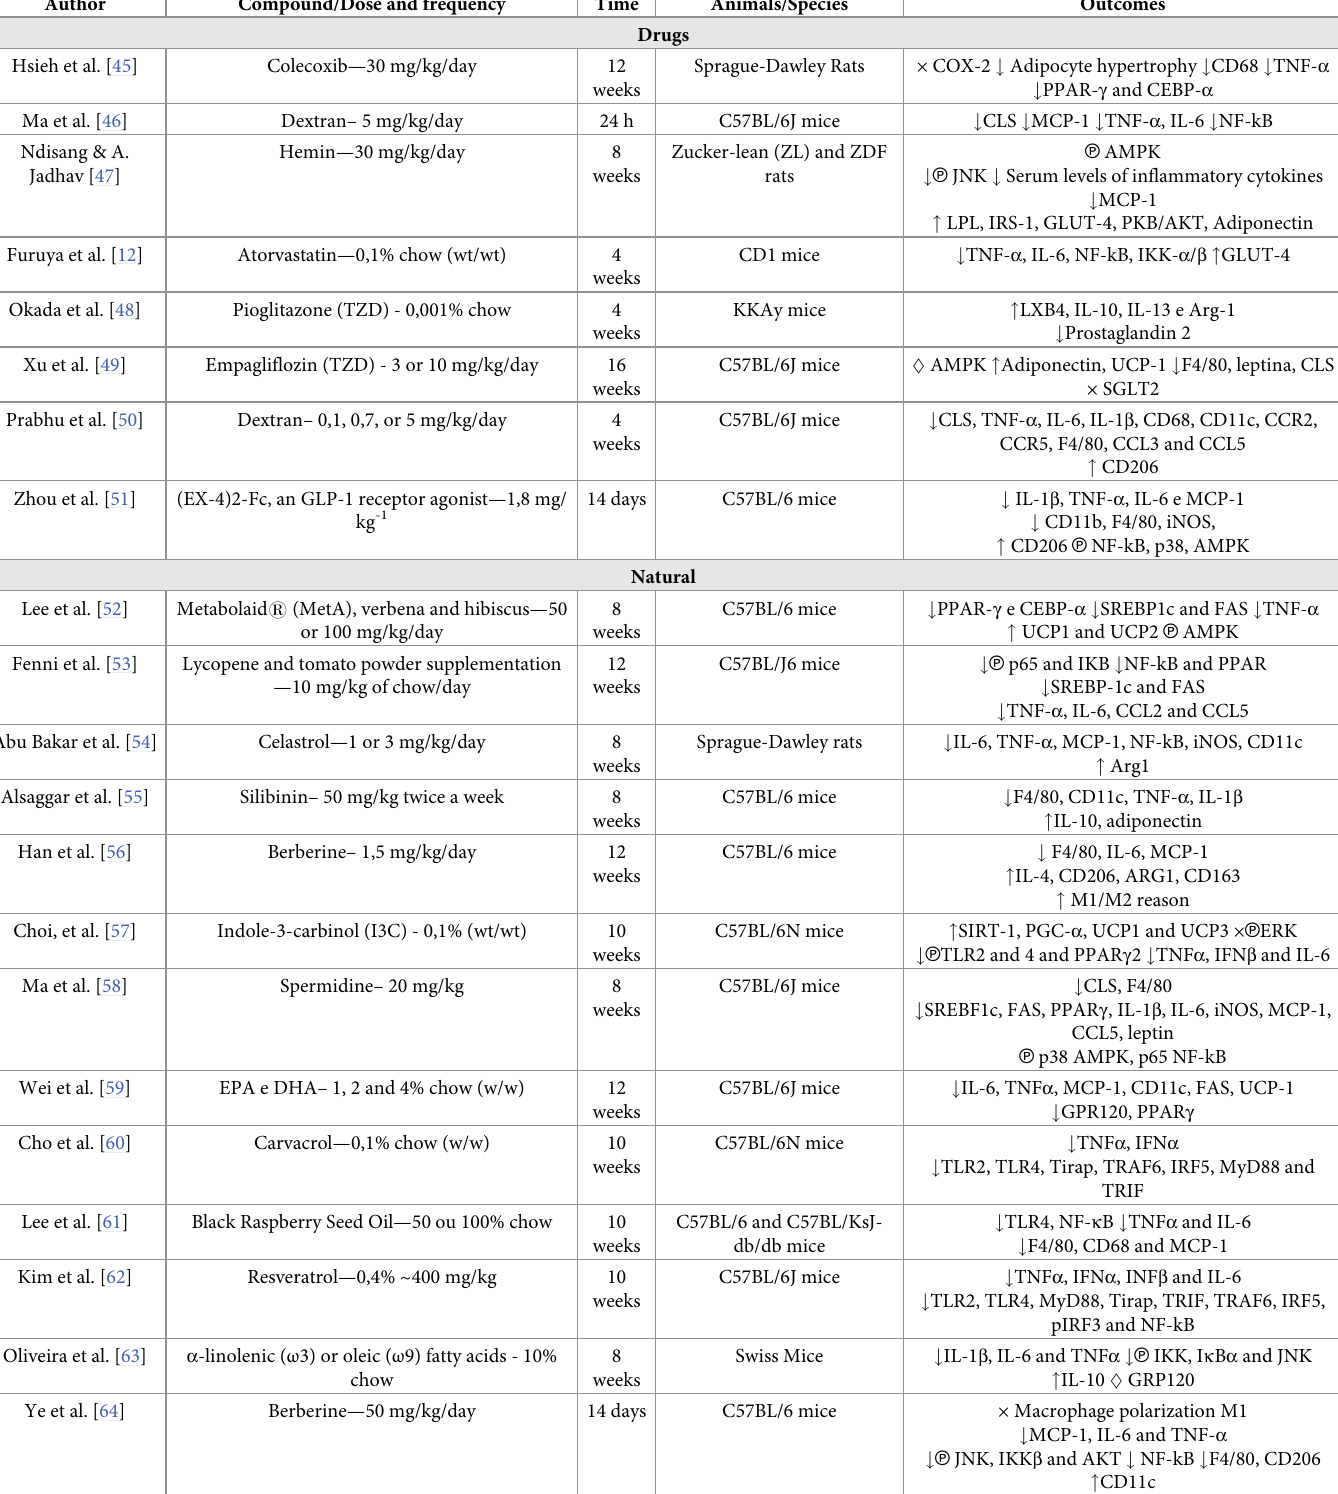
Table 2. Characteristics of the studies selected for the systematic review separated by categories of anti-inflammatory agents, revealing the outcomes to answer the question: What are the mechanisms of action of anti-inflammatory agents in adipose tissue?.